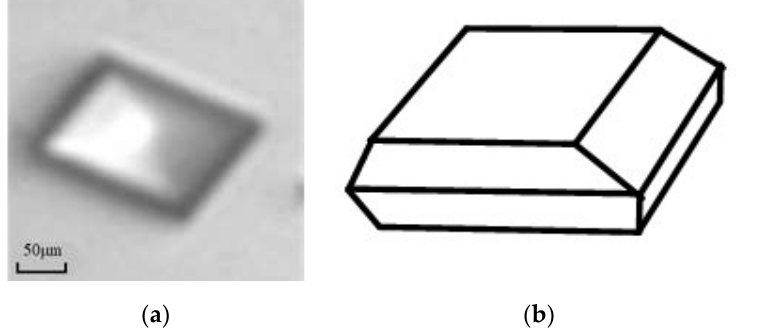
Figure 1. The crystal morphology of α-form LGA: ( a ) crystal image of α-form LGA; ( b ) schematic representation of α-form LGA.